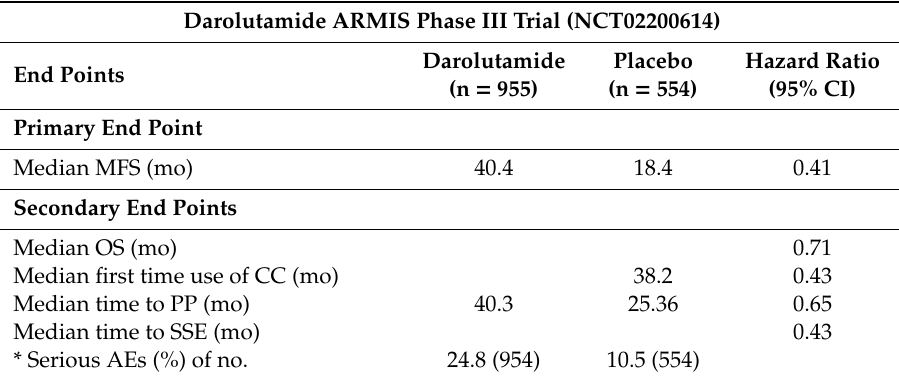
Table 9. Major therapeutic benefits brought by darolutamide based on